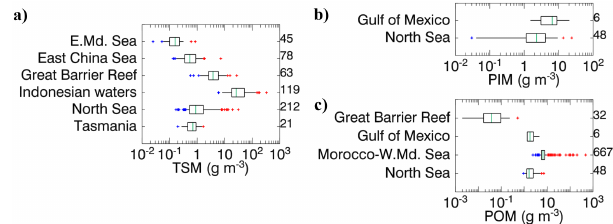
Figure 8. The distribution of (a) TSM (gm − 3 ), (b) PIM (gm − 3 ) and (c) POM (gm − 3 ) as given in the in situ data set at all measure- ment depths. The number of measurements taken at each test site is reported on the right axis of the graphs. The graphical convention is identical to Fig. 6. Figure 9. The distribution of (a) turbidity (FNU for the North Sea